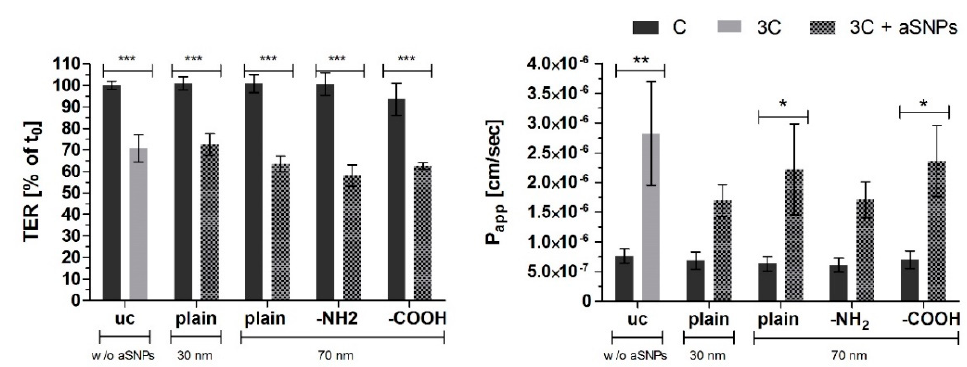
Figure 6. TER: Transepithelial electrical resistance measurements (% of t0), t0: time point prior to stimulation of each well, respectively; P app : the apparent permeability coe ffi cient (cm / s)) of NaFlu through the coculture CC (Caco-2 / ISO-HAS-1) after stimulation of the inverted coculure CCinc (ISO-HAS-1 / Caco-2) with aSNPs and 3C (cytokine mixture ((IL-1 β (100 U / mL), TNF- α (600 U / mL) and IFN- γ (200 U / mL)) for 48 h; uc: untreated control (without aSNP and 3C); aSNPs: -plain, 30 nm: Sicastar Red with a diameter of 30 nm, without surface modifications; -plain, -NH2, -COOH, 70 nm: Sicastar Red with a diameter of 70 nm and di ff erent surface modifications. All aSNPs were applied in a concentration of 100 µ g / mL. Data are depicted as means ± SE of three independent experiments with n = 3. For statistical analysis one-way ANOVA with Dunnett’s Multiple Comparison test was conducted. * p < 0.05, ** p < 0.01, *** p < 0.001.